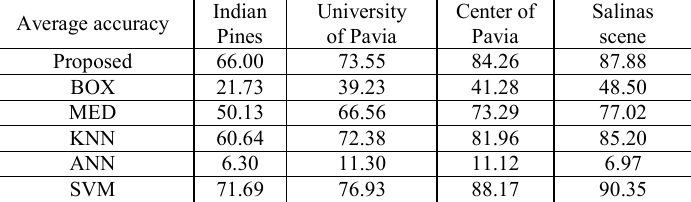
Table 1. Summary of comparison of accuracy of classifiers for different